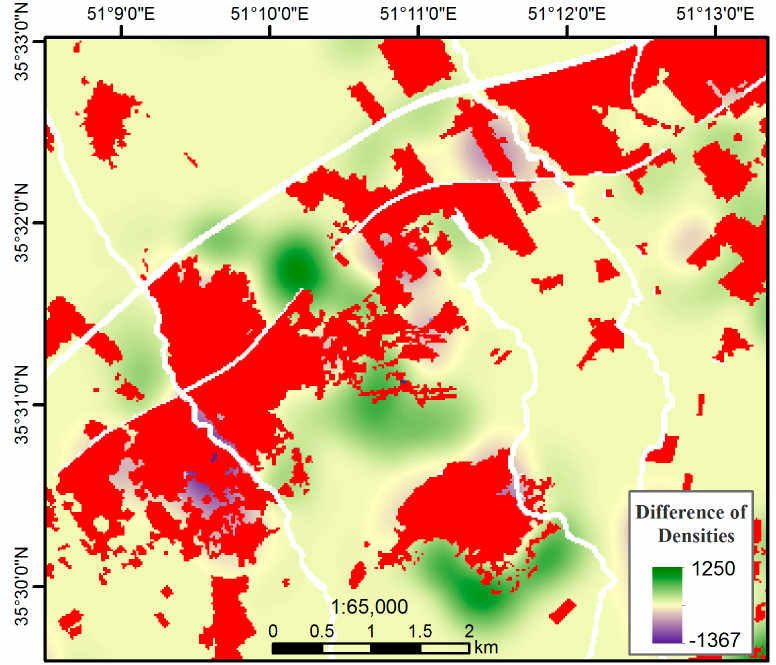
Figure 13. Differences in the density of urban development in the periods of 1996–2002 and 1992–1996 near the cities of Golestan and